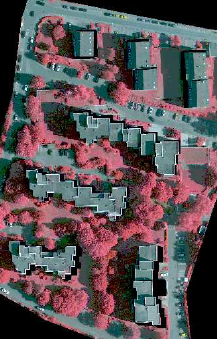
Figure 6. Figure shows 3D model of area 2 after applying the approach.